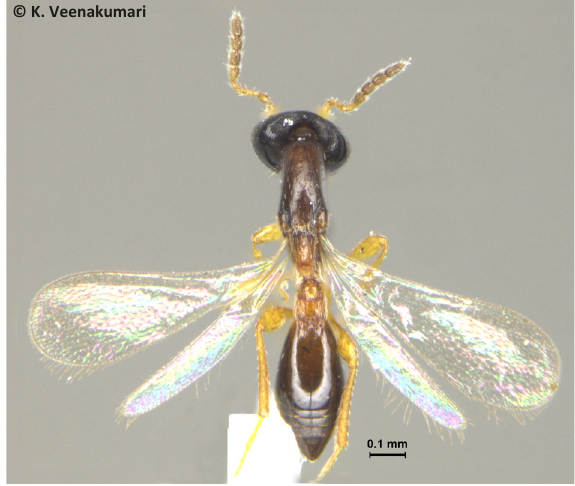
Image 1. Piestopleura sp. (female)